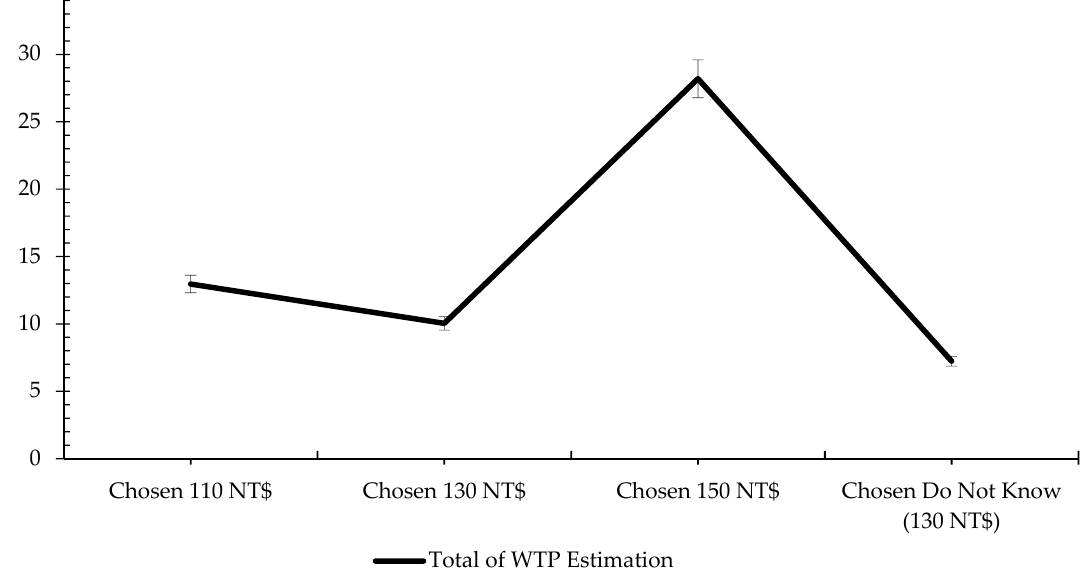
Figure 2. The total estimation of WTP for nutrition information. Note: The error bars denote statistical significance at 5% significance. Source: Illustrated by this research.